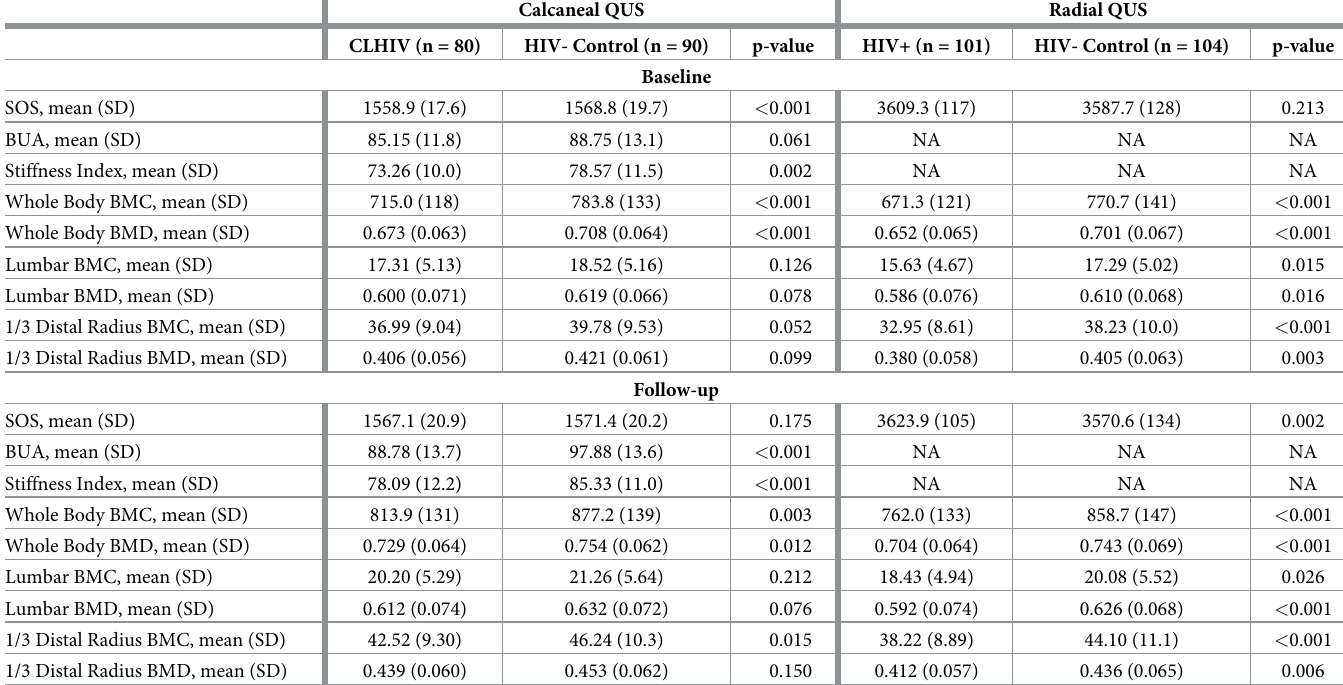
Table 3. Comparison of baseline and follow-up QUS and DXA measures between CLHIV and uninfected